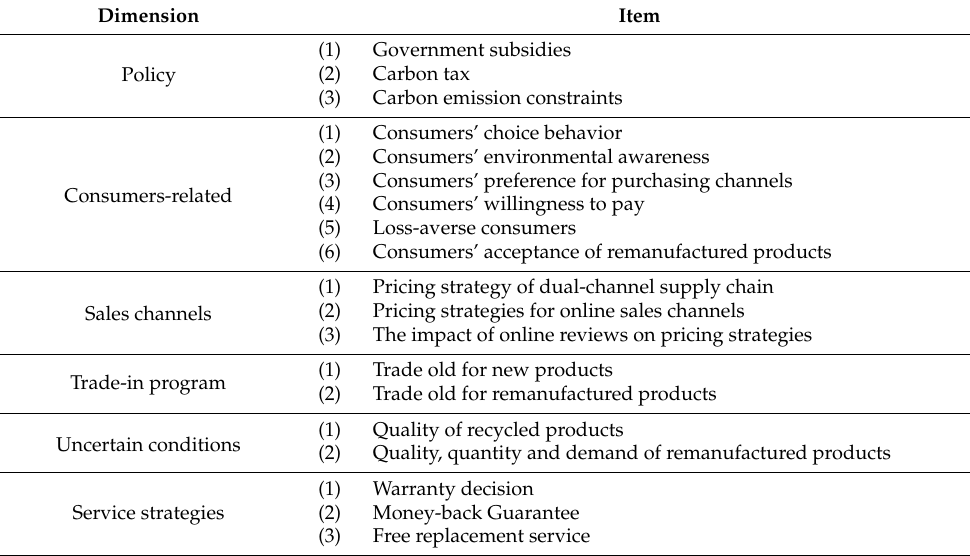
Table 4. Factors considered in pricing in remanufacturing